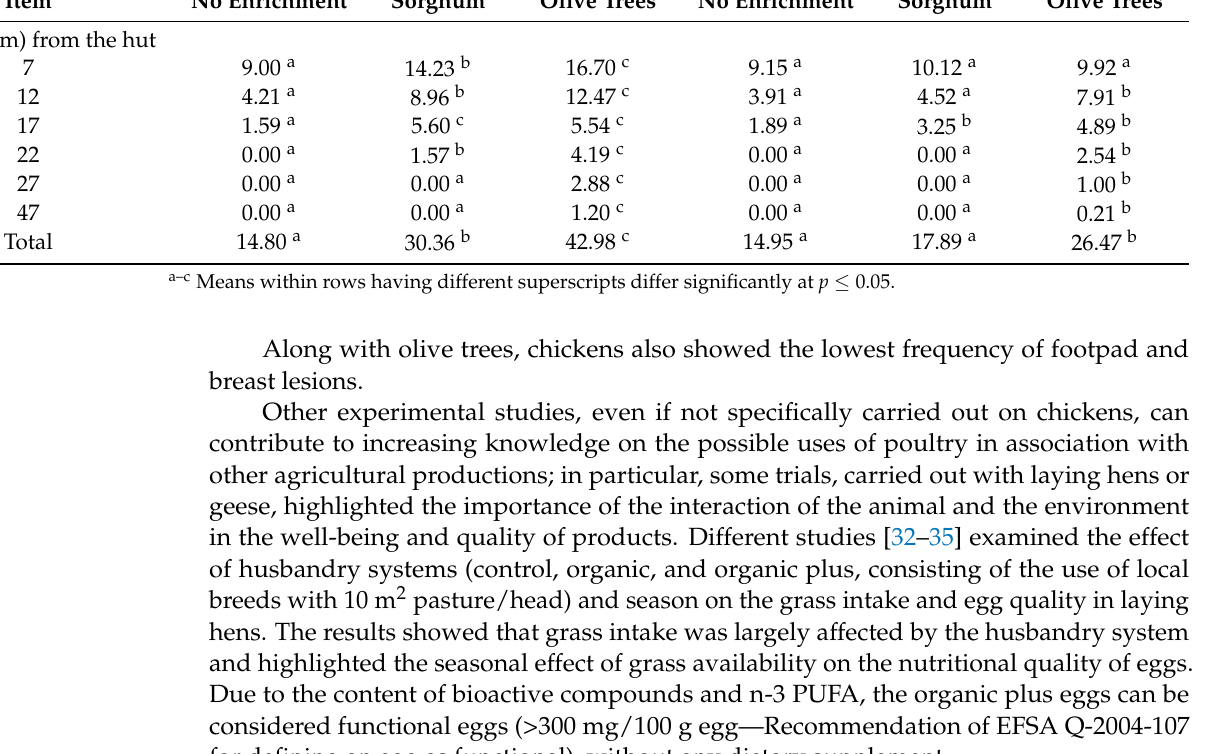
Figure 10. Schematic representation of the different rearing systems: ( A ) = no enrichment; ( B ) = sorghum; ( C ) = olive trees. (Each pen measured 1000 m² each exclusion pen). Modified by [31]. Table 6. Estimated grass intake of chickens (g of dry matter/d per bird). Modified from [31]. Summer Winter Olive Trees Sorghum Olive